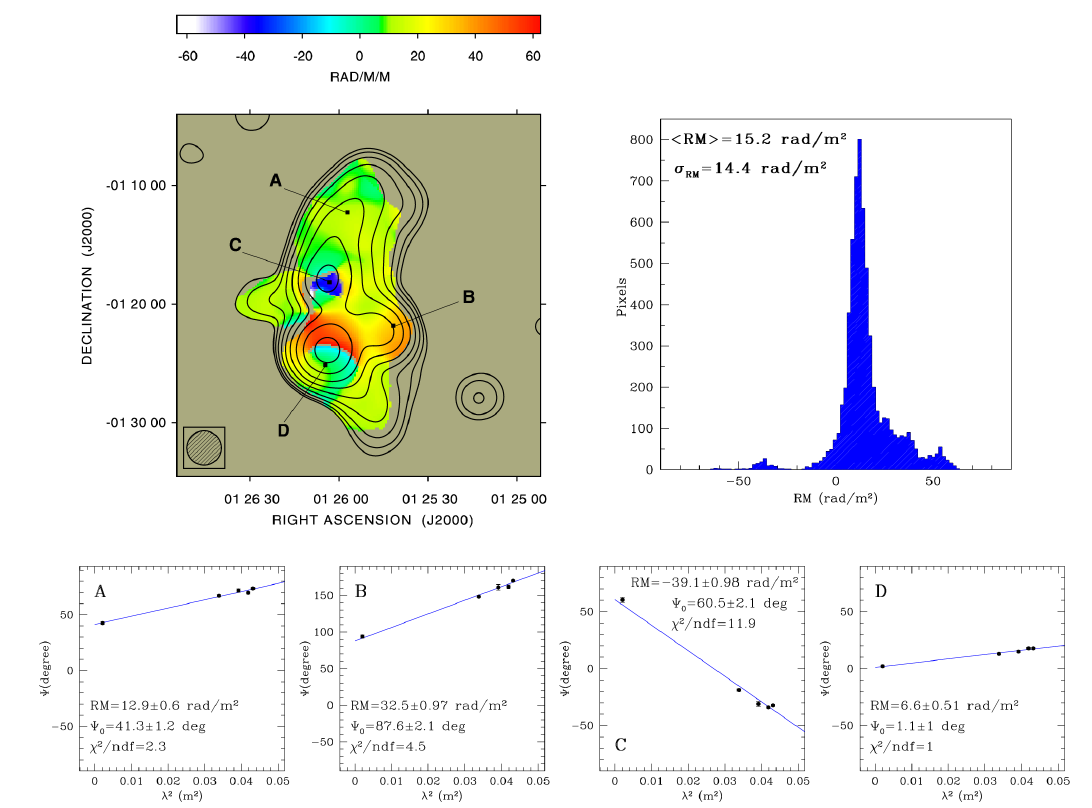
Figure 2. Top left: Total intensity emission at 1.4MHz of the radio sources at the center of A194 overlaid on the rotation measure image derived by using radio observations between 1.4 and 6.6GHz, smoothed with a FWHM Gaussian of 2.9 (cid:48) . Top right: histogram of the rotation measure distribution. Bottom: plots of the polarization angle Ψ versus the square wavelength λ 2 at four different source locations. These images have been produced in the context of the work